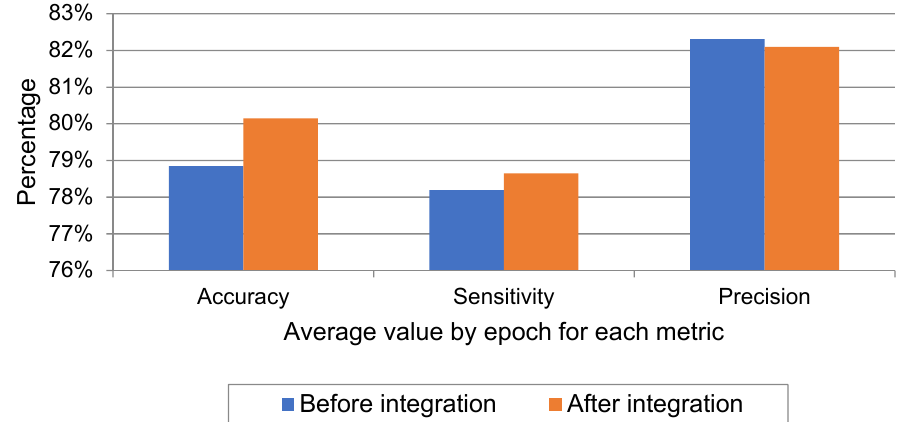
Figure 6. Average values of experiments before and after data integration for performance metrics.